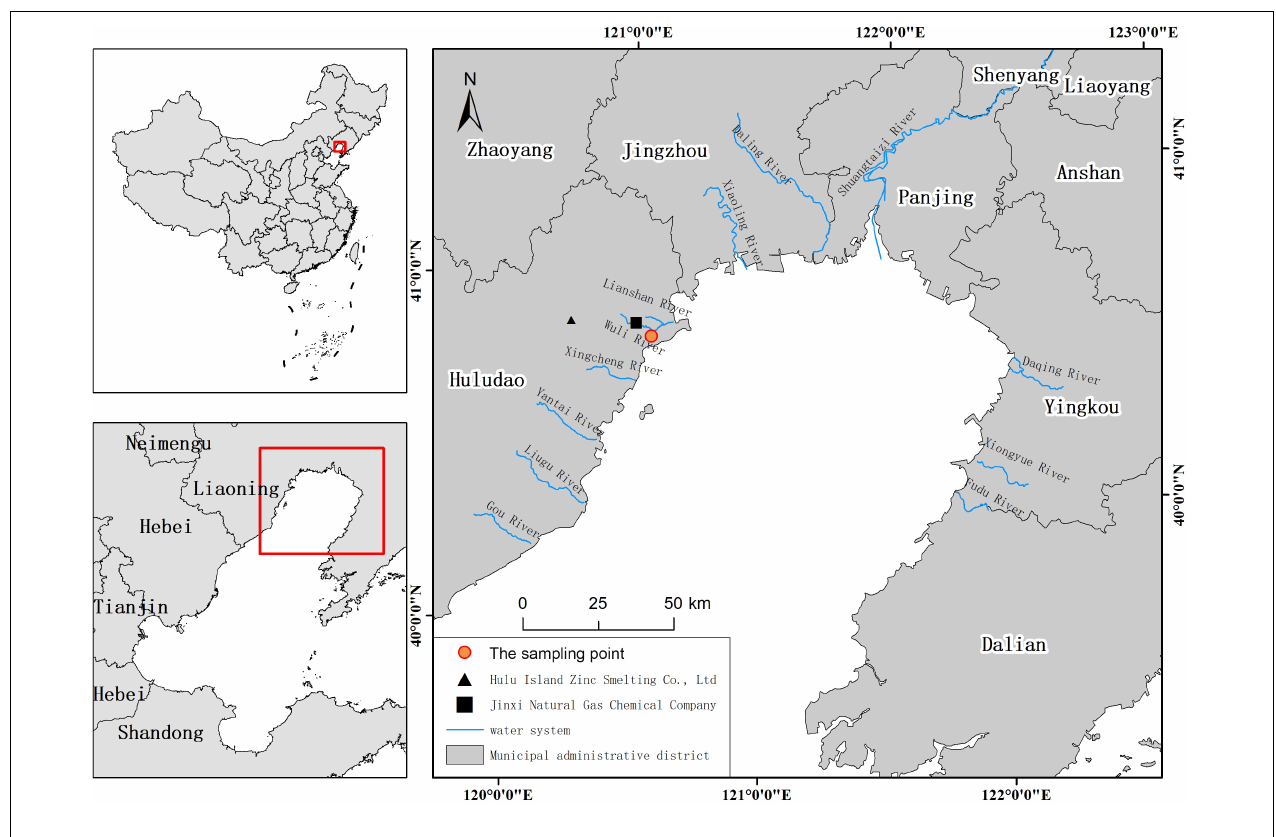
FIGURE 1 | Location of the study area and sampling site. TABLE 1 | Fish species collected from Liaodong Bay from 2015 to